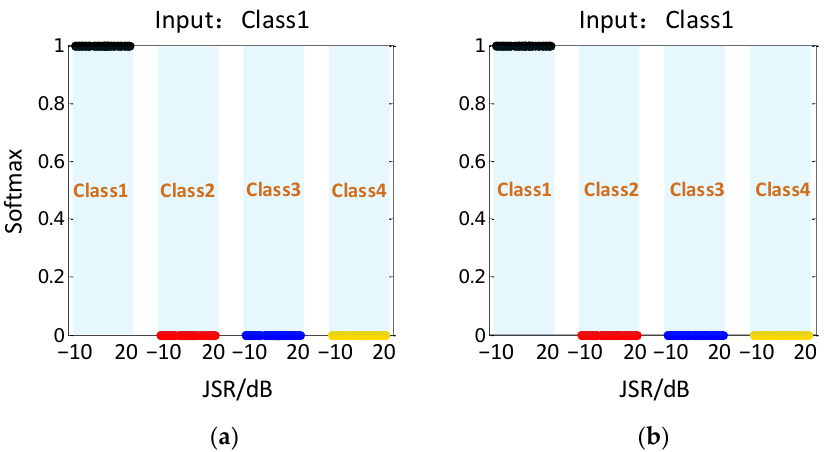
Figure 7. Recognition results with different JSRs when the input is Class1. ( a ) CV-CNN, ( b ) RV-CNN.